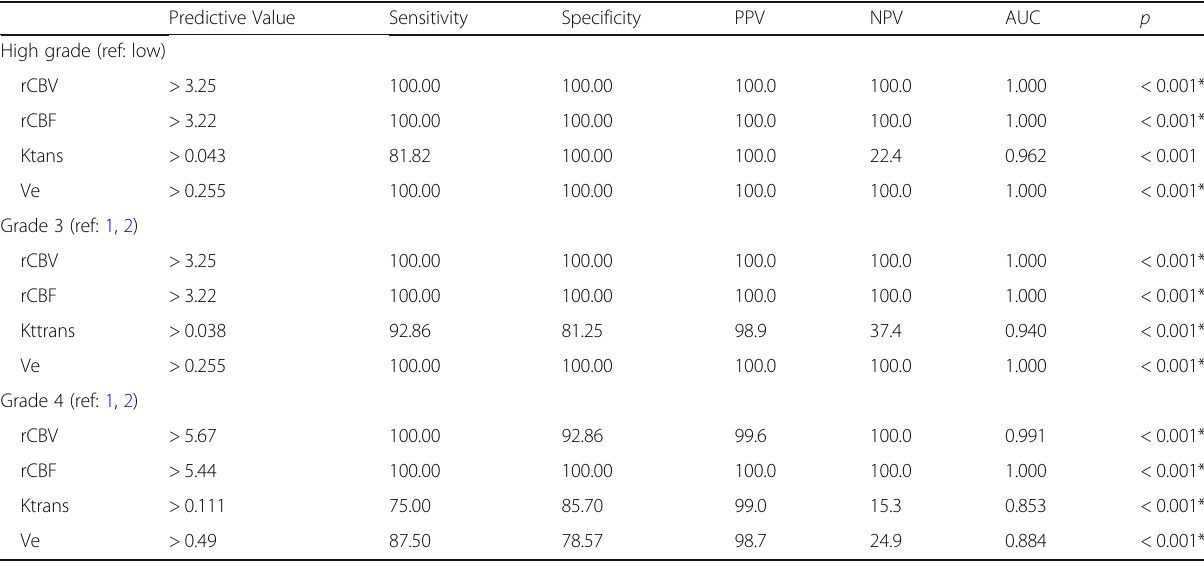
Table 4 Diagnostic value of the variables according to grade subgroups Predictive Value Sensitivity Specificity PPV NPV